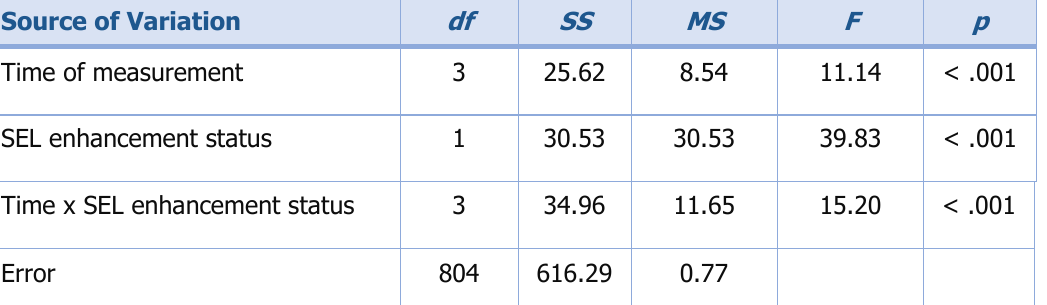
Table 7. Effects of Time of Measurement and of SEL Enhancement Status in Years 1 and